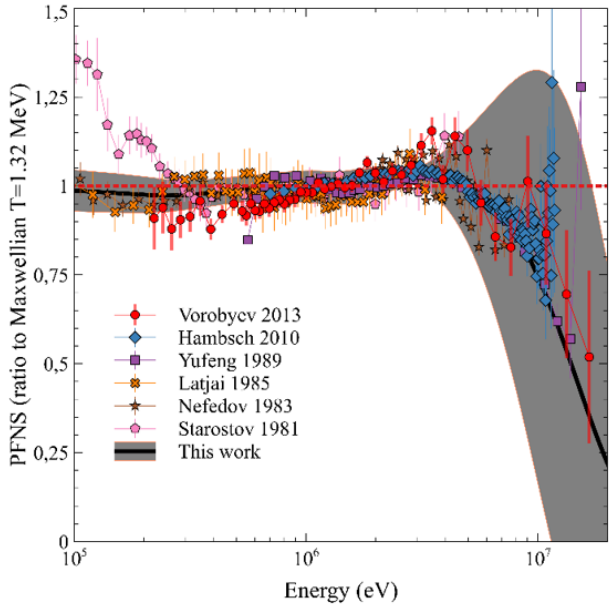
Fig. 9. 235 U thermal neutron induced prompt fission neu- tron spectra evaluation with CONRAD. Comparison between experiment and theory (Madland-Nix Los Alamos model) are given, as well as an uncertainty evaluation. Figure courtesy of A.